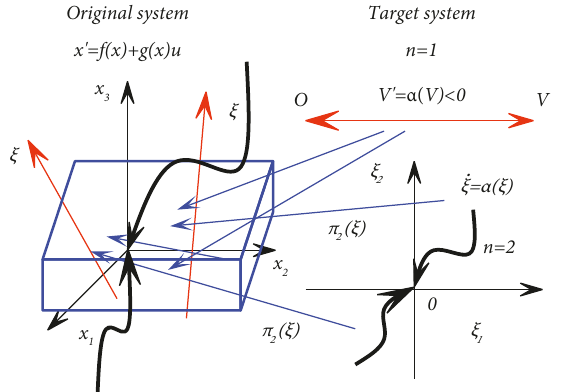
Figure 1: Schematic diagram of the immersion invariant